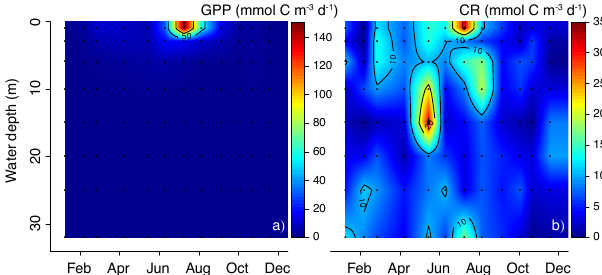
Figure 5. Volumetric rates of (a) GPP (mmol Cm − 3 d − 1 ) and (b) CR (mmol Cm − 3 d − 1 ) at Den Osse in 2012. Black dots indicate sampling intervals. Rates were calculated as described in Sect. 2.4.